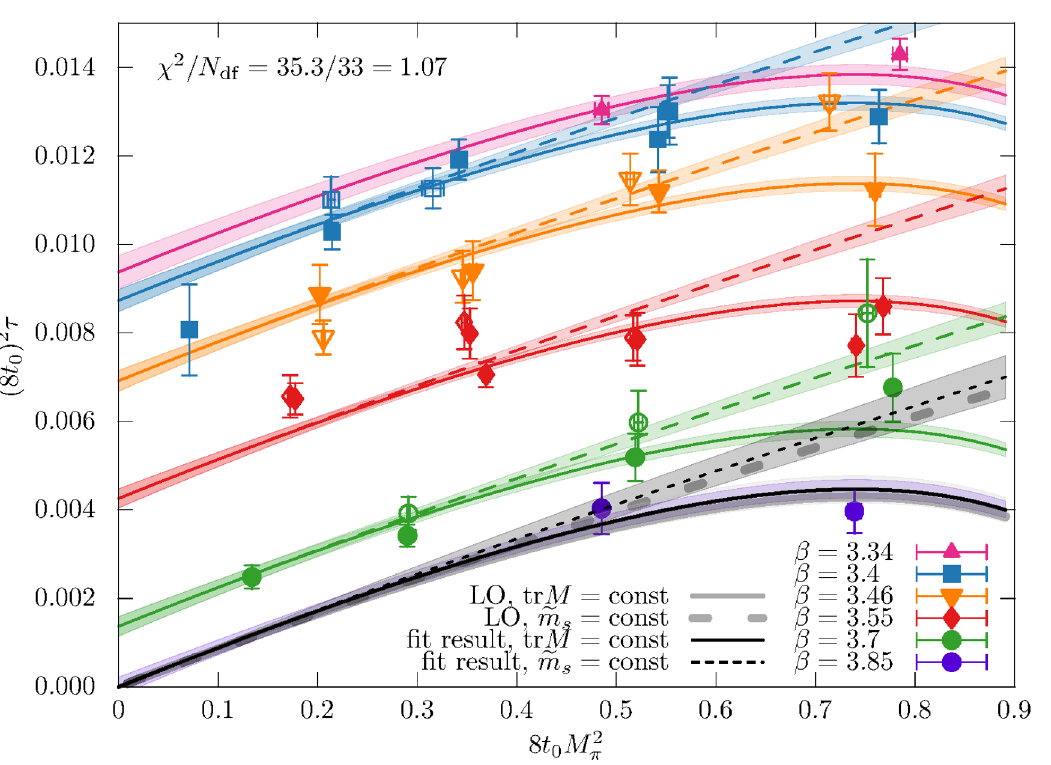
Figure 9. Topological susceptibility for many of the CLS ensembles described in [47]. Filled symbols mark ensembles that are simulated with a constant sum of quark masses (solid lines), open symbols correspond to ensembles with the strange quark mass fixed to approximately the physical value (dashed lines). Lines and shaded regions are the result of a fit to eq. (6.27). The continuum limit result (black lines) is very close to both the fit result at β = 3 . 85 as well as the leading order √ expectation (grey lines), when using 8 t 0 F = 0 . 1866 , see eq. (5.59), and setting Z ω = 1